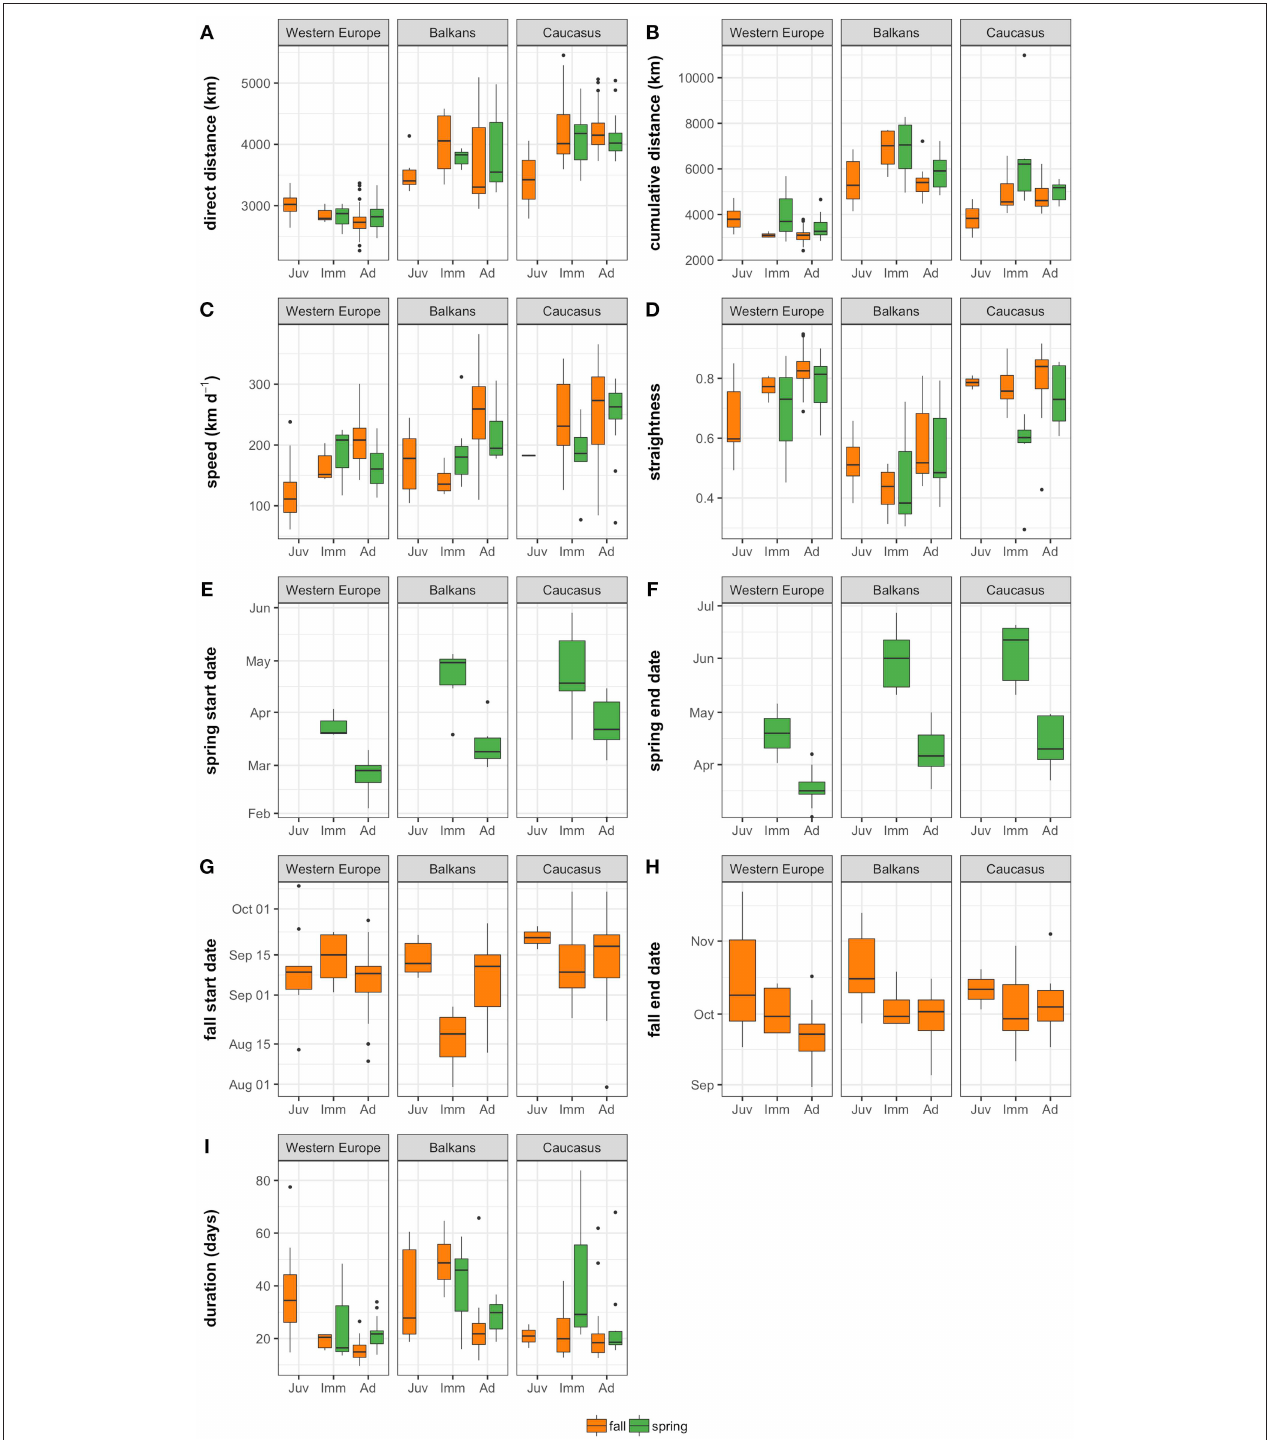
FIGURE 3 | Boxplots showing median and inter-quartile range of Egyptian Vulture migration parameters by season, age class (Juv. = hatch year; Imm. = 2nd − 5th calendar year; Ad. = 6th calendar year and older), and subpopulation. (A) Direct distance is the distance between summer and winter ranges; (B) cumulative distance is the summed distances between each successive point in the migration trajectory; (C) migration speed (km d − 1 ) is the cumulative migration distance divided by the migration duration; (D) straightness is the ratio between the direct and cumulative distance; migration start (E,G) and end (F,H) are the days on which migration initiated and concluded; and (I) migration duration is the number of days spent on migration. Orange and green bars indicate fall and spring migrations, respectively. Only parameters from complete migration trajectories were included (refer to Supplementary Table 1 for sample sizes).